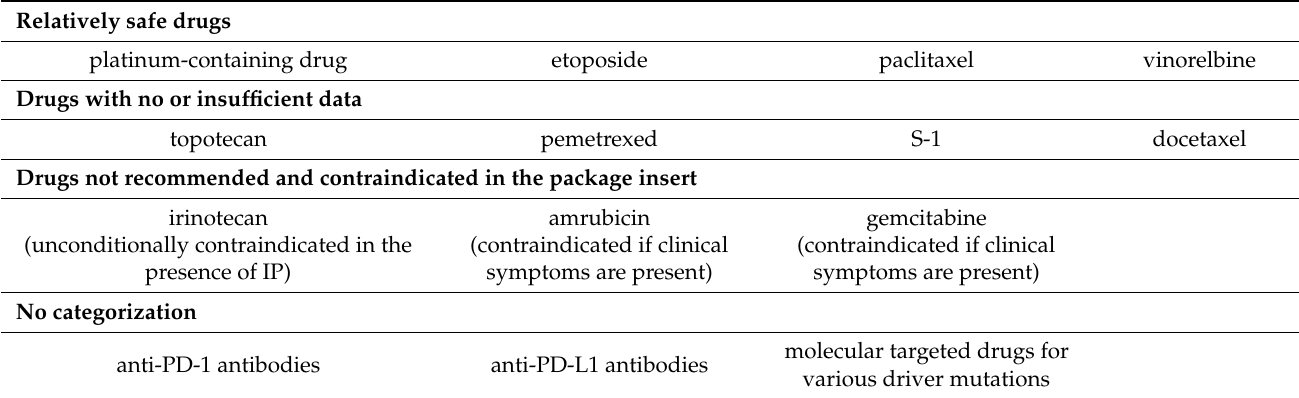
Table 1. Categorization of each drug in the Japanese Respiratory Society statement for the treatment of lung cancer with comorbid